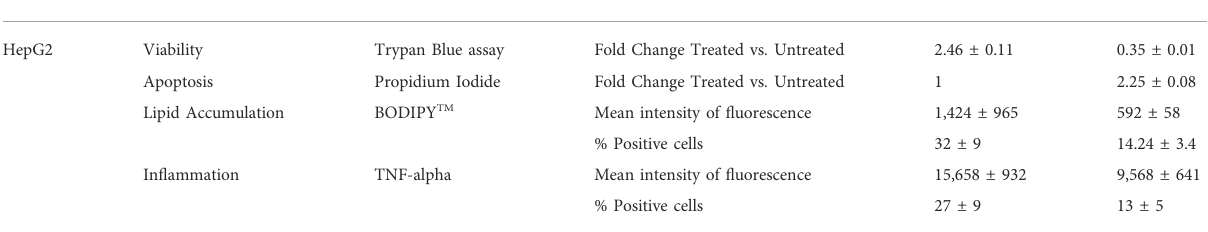
TABLE 2 Effect of mol- miRs on HepG2 cells.